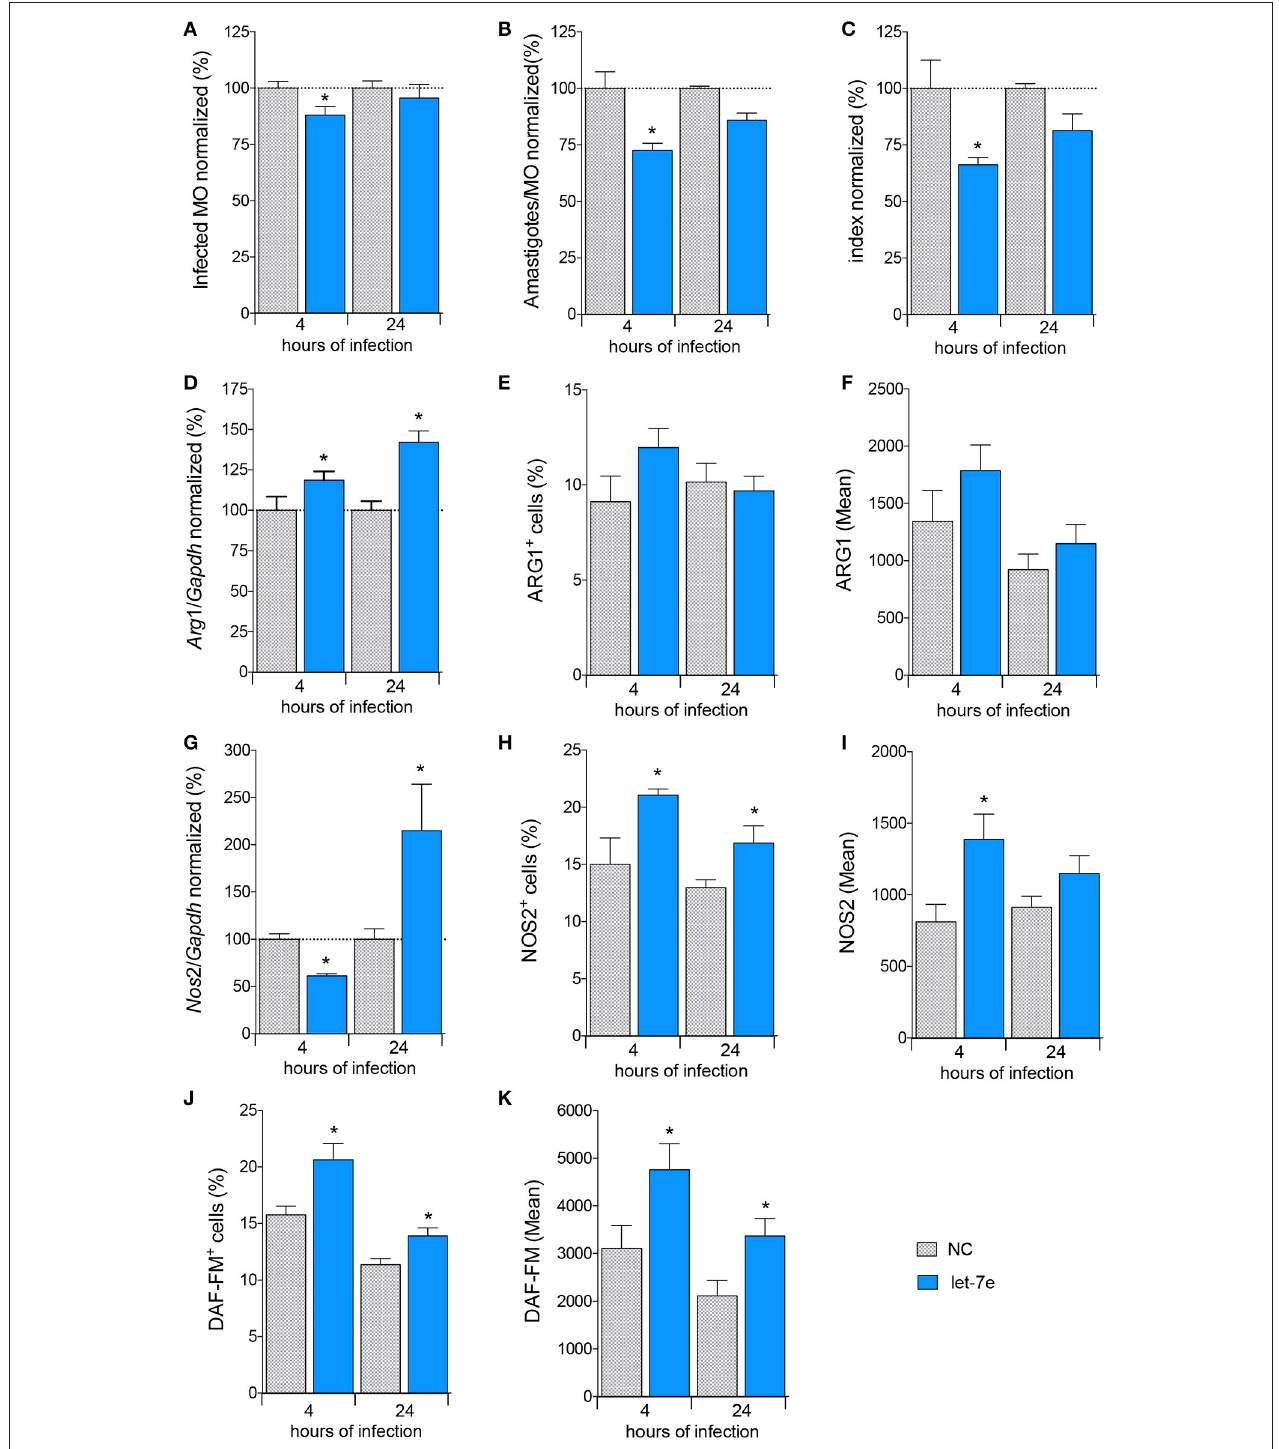
FIGURE 5 | Inhibition of let-7 increases differential gene expression and reduces L. amazonensis infectivity. BMDMs were transiently transfected with 100nM negative control (NC—filed patterned bar) or let-7e-5p inhibitor (let-7e—blue bar). Twenty-four hours after transfection, the cells were co-cultivated with L. amazonensis (MOI 5:1) for 4h, and the cultures were then washed. Four and 24h after infection, the samples were analyzed for infectivity under the microscope by counting the numbers of infected macrophages (A) , amastigotes per infected macrophage (B) , and infectivity index (C) ( n = 1,000 macrophages/treatment). RT-qPCR was used to